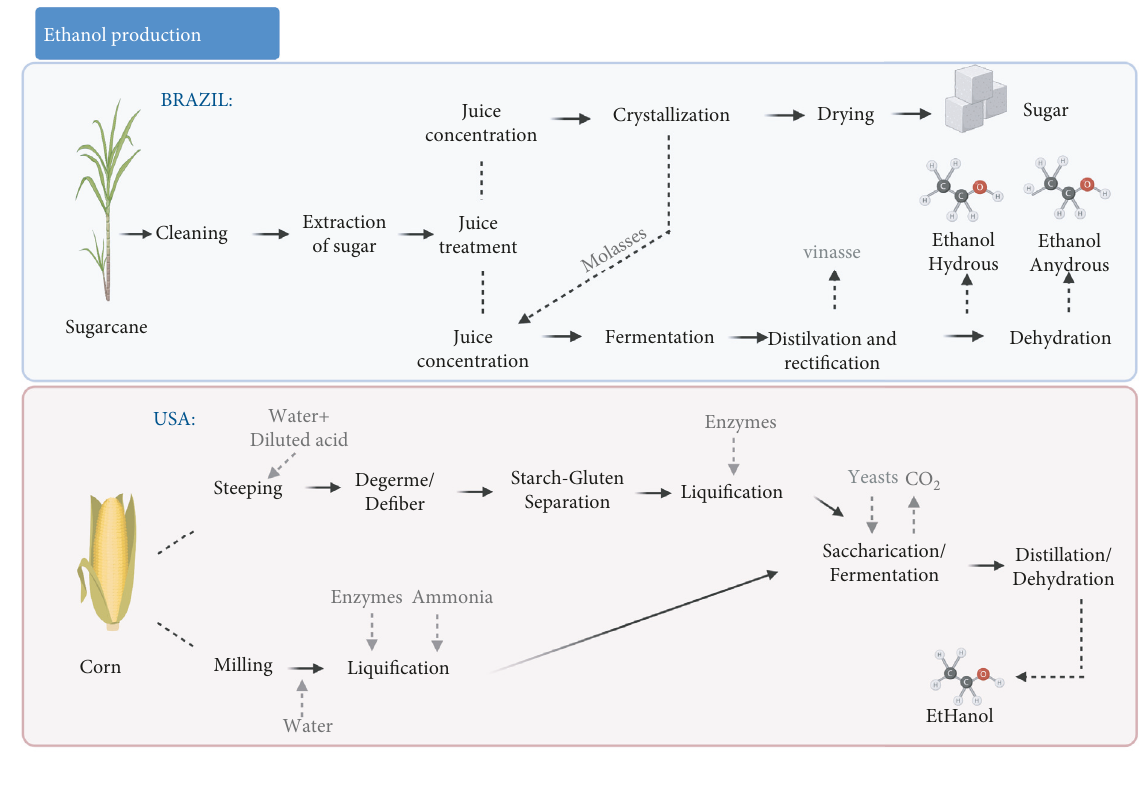
Figure 3: Ethanol production process using corn (in USA) and sugarcane (in Brazil) as substrate.